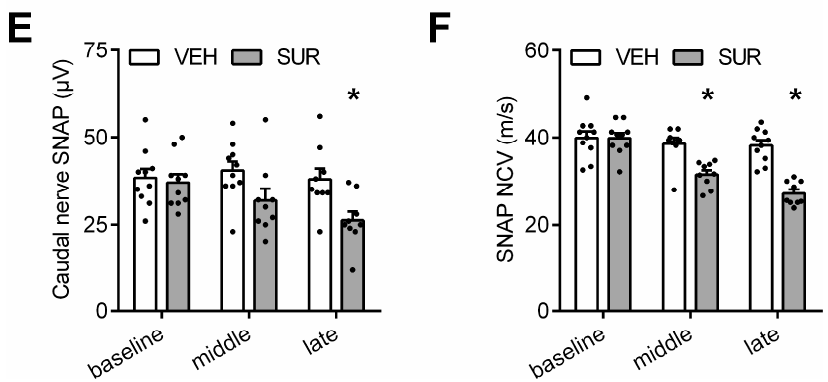
Figure 1. Mouse model of suramin-induced sensory-motor polyneuropathy. ( A ) Schematic outline of the experiment: Adult C57Bl/6 mice received a single intraperitoneal injection of 250 mg/kg bodyweight suramin (SUR) or vehicle (VEH) on day 0. Mice were tested on the rotarod (RR) and with the von Frey (vF) test for locomotor deficits and alterations of mechanical withdrawal threshold four times. Electropysiological (Ephys) measurements were obtained on day 0, 8 and 13; ( B ) SUR treated mice showed a decline in body weight, but recovered by day 13. One animal had to be sacrificed due to weight loss >20%; ( C ) SUR application resulted in a decrease of the mechanical withdrawal threshold and ( D ) locomotor function, which was most pronounced on day 8; ( E ) SUR treated mice showed a decline of the sensory nerve action potential (SNAP) amplitude as well as the ( F ) SNAP nerve conduction velocity (NCV), indicative of an axonal-demyelinating neuropathy. Group sizes: n = 10 (vehicle), n = 9–10 (suramin), * p <